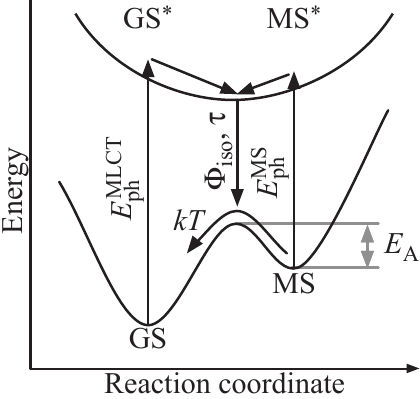
Figure 2. Scheme of a light-induced linkage isomerization in a transition metal